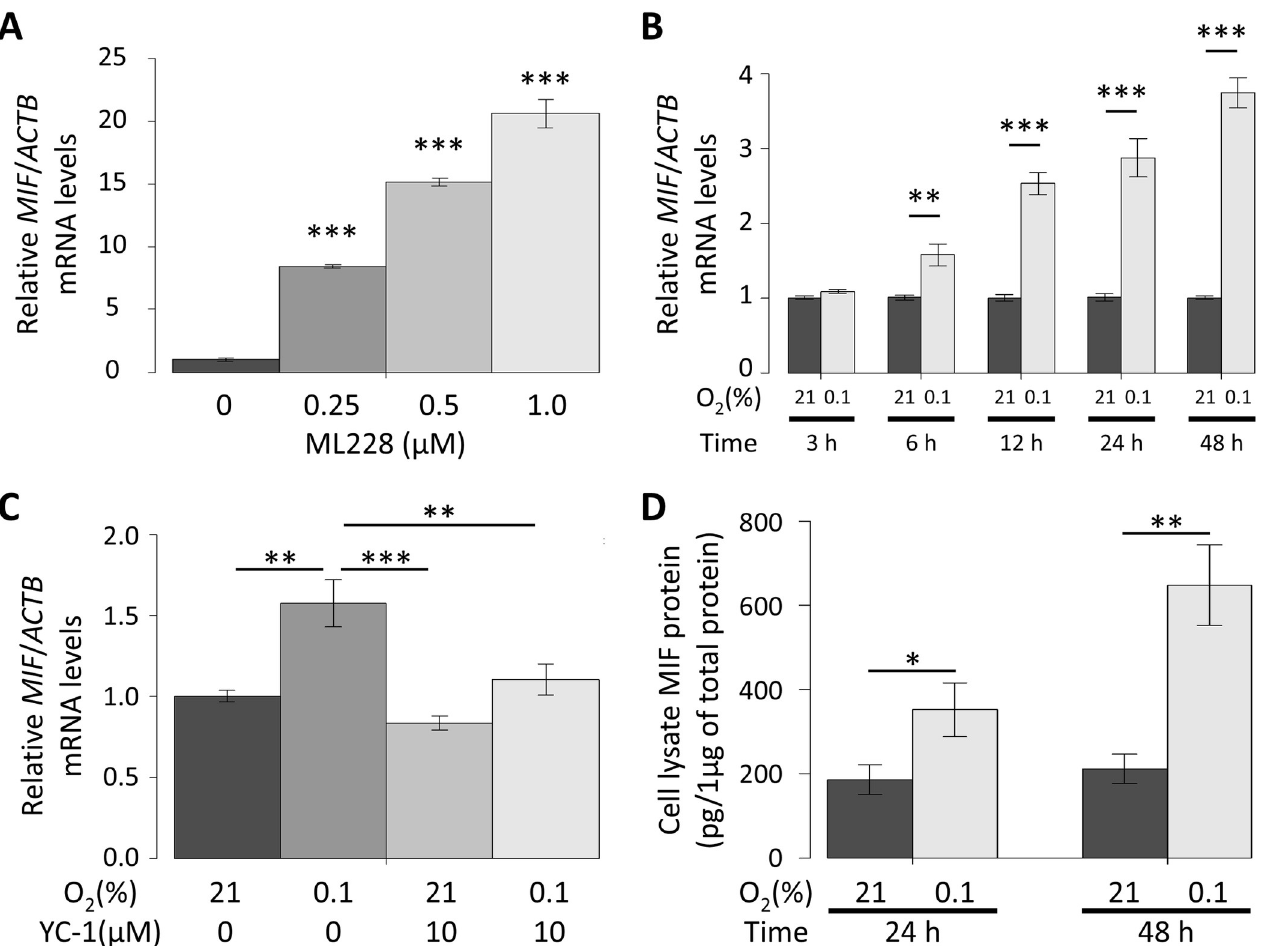
Fig 2. Hypoxia induced macrophage migration inhibitory factor ( MIF ) mRNA expression and protein production via the hypoxia inducible factor (HIF) pathway. A. The effects of ML228, a HIF activator, on MIF mRNA expression in primary cultured astrocytes (PCAs). PCAs were incubated for 48 h in 0, 0.25, 0.5, or 1.0 μ M ML228. MIF mRNA expression was analyzed by qRT-PCR. The values are shown as the ratio of MIF mRNA to beta-actin ( ACTB ) mRNA (Dunnett’s test vs. vehicle; n = 3). B. The time-dependent effects of hypoxia on MIF mRNA expression in PCAs. PCAs were incubated for 3, 6, 12, 24, or 48 h in 21.0% or 0.1% O 2 . MIF mRNA expression was analyzed by qRT-PCR. The values are shown as the ratio of MIF mRNA to ACTB mRNA (Student’s t-test; n = 5–6). C. The effects of the HIF inhibitor YC-1 on hypoxia-induced MIF mRNA expression in PCAs. PCAs were incubated for 6 h in 21.0% or 0.1% O 2 and treated with 0 or 10 μ M of YC-1. MIF mRNA expression was analyzed by qRT-PCR. The values are shown as the ratio of MIF mRNA to ACTB mRNA (Tukey’s test; n = 6). D. The effects of hypoxia on MIF protein production in cell lysate of PCAs. PCAs were incubated for 24 or 48 h in 21.0% or 0.1% O 2 . The MIF protein level per 1 μ g of total protein was analyzed using a MIF enzyme-linked immunosorbent assay (ELISA) (Student’s t-test; n = 6). The data are expressed as the mean ± SEM. � p < 0.05, �� p < 0.01, or ��� p < 0.001.